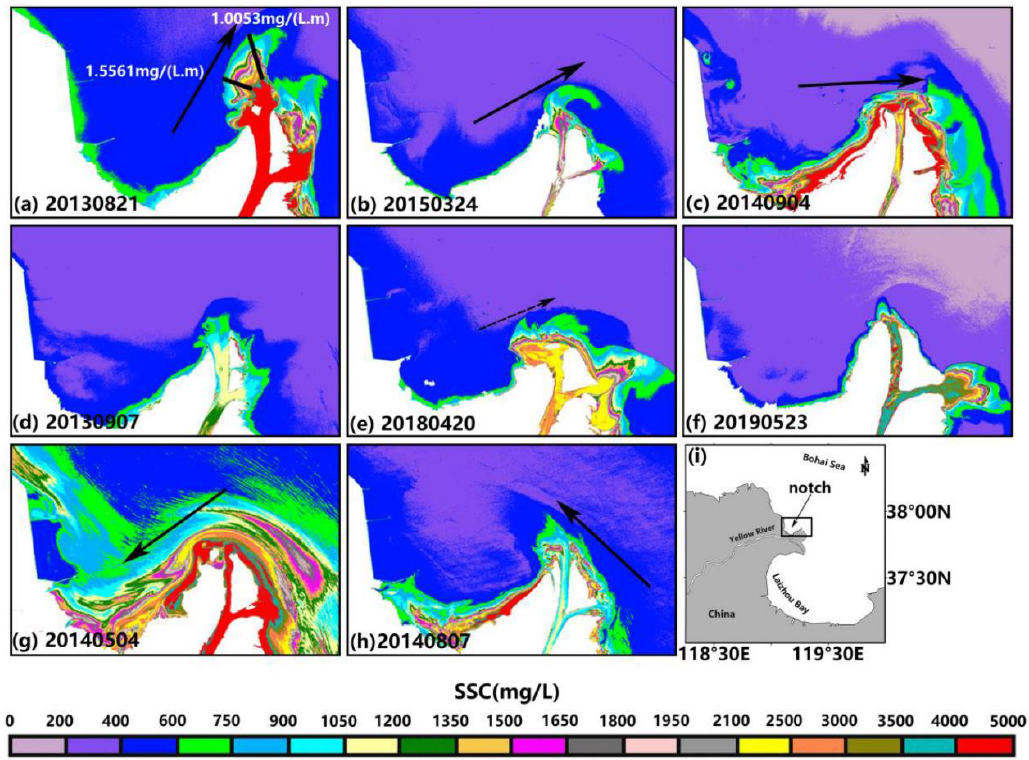
Figure 5. SSC distribution in the notch at the left side of the estuary. The black arrows in the picture indicate the current directions. The black dotted arrow in ( e ) indicates that the current is weak. The black box in ( i ) is the area of the retrieved images in the study area.